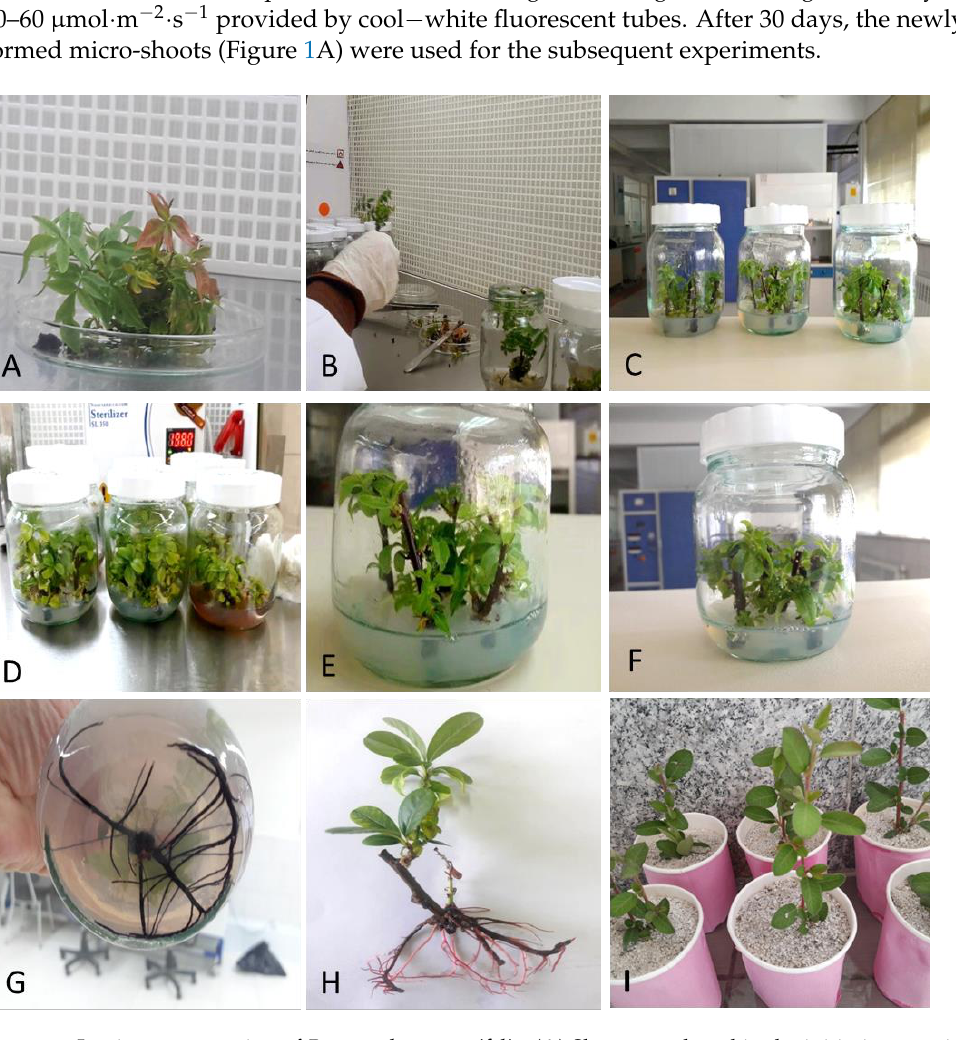
Figure 1. In vitro propagation of Pyracantha angustifolia . ( A ) Shoots produced in the initiation step in the MS medium containing 0.5 mg·L −1 GA 3 . ( B ) Preparation of the explants (nodal segments with axillary buds) for the multiplication step. ( C ) Micro-shoots produced in the proliferation step (LS medium containing 3 mg·L −1 BAP (left), 2 mg·L −1 BAP (medial), and 2.5 mg·L −1 BAP (right)). ( D ) Micro-shoots produced in the proliferation step (MS medium containing 2 mg·L −1 BAP (left), 2.5 mg·L −1 BAP (medial), and 3 mg·L −1 BAP (right)). ( E ) Micro-shoots produced in the MS medium con- taining 2.5 mg·L −1 BAP. ( F ) Micro-shoots produced in the WPM containing 2.5 mg·L −1 BAP. ( G ) Rooted micro-shoots in the MS medium containing 1 mg·L −1 IBA. ( H ) Plantlets obtained from the MS medium containing 1 mg·L −1 IBA. ( I ) Acclimatization of the plantlets in plastic pots filled with perlite and peat moss (2:1) in the acclimatization room. 2.4. Shoot Proliferation After the establishment and growth of the micro-shoots, a total of 108 nodal explants with axillary buds (Figure 1B) were used as secondary explants in the proliferation stage (Figure 1C – F). Three types of basal culture media – MS, woody plant medium (WPM) [20], and Linsmaier and Skoog (LS) [21] — containing 3% sucrose and 0.8% agar were prepared. The pH levels of the media were adjusted to 5.6 – 5.8 before autoclaving as described above. The media were augmented with different concentrations of BAP (0, 2, 2.5, and 3 mg·L −1 ) for the induction of direct organogenesis. In all experimental objects, 0.3 mg·L −1 GA 3 and 0.1 mg·L −1 IBA were used for hormonal balance. Jars of jam were used as the culture ves- sels and 50 mL of medium was poured into each jar. All the cultures were incubated at 24 ± 2 °C and a 16 h photoperiod of 50 –60 μmol·m −2 ·s −1 irradiance was provided by cool−white fluorescent tubes. The produced micro-shoots were sub-cultured twice after 30 days.